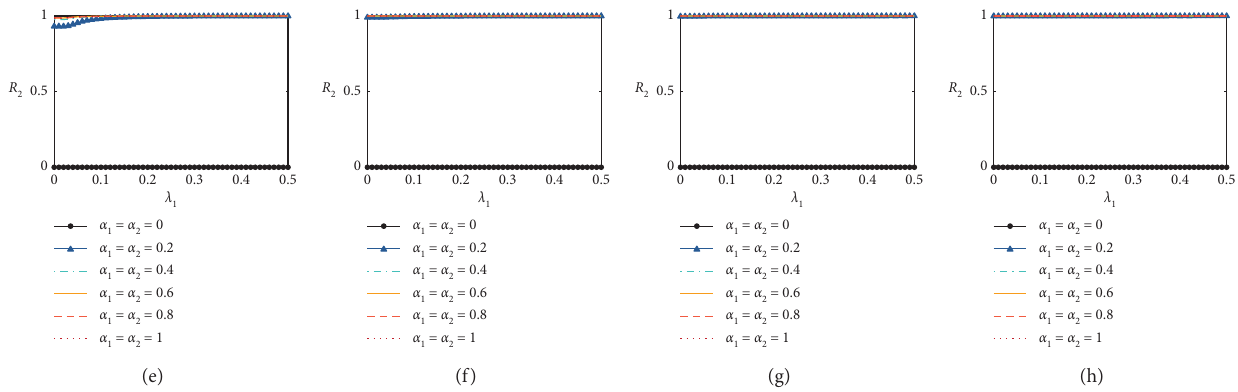
Figure 3: Virus spreading size R with (a) λ parameters are set to be c